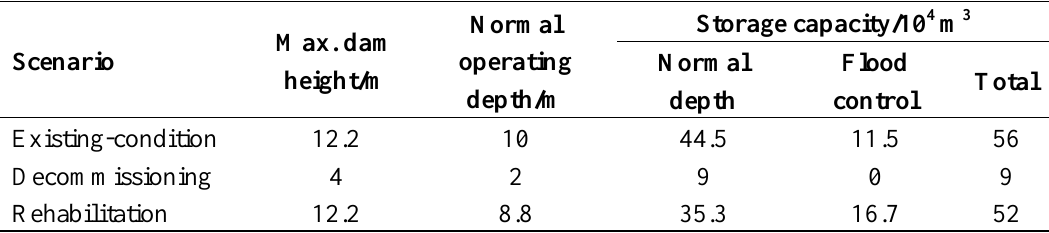
Table 1. Summary of the key physical characteristics of the management